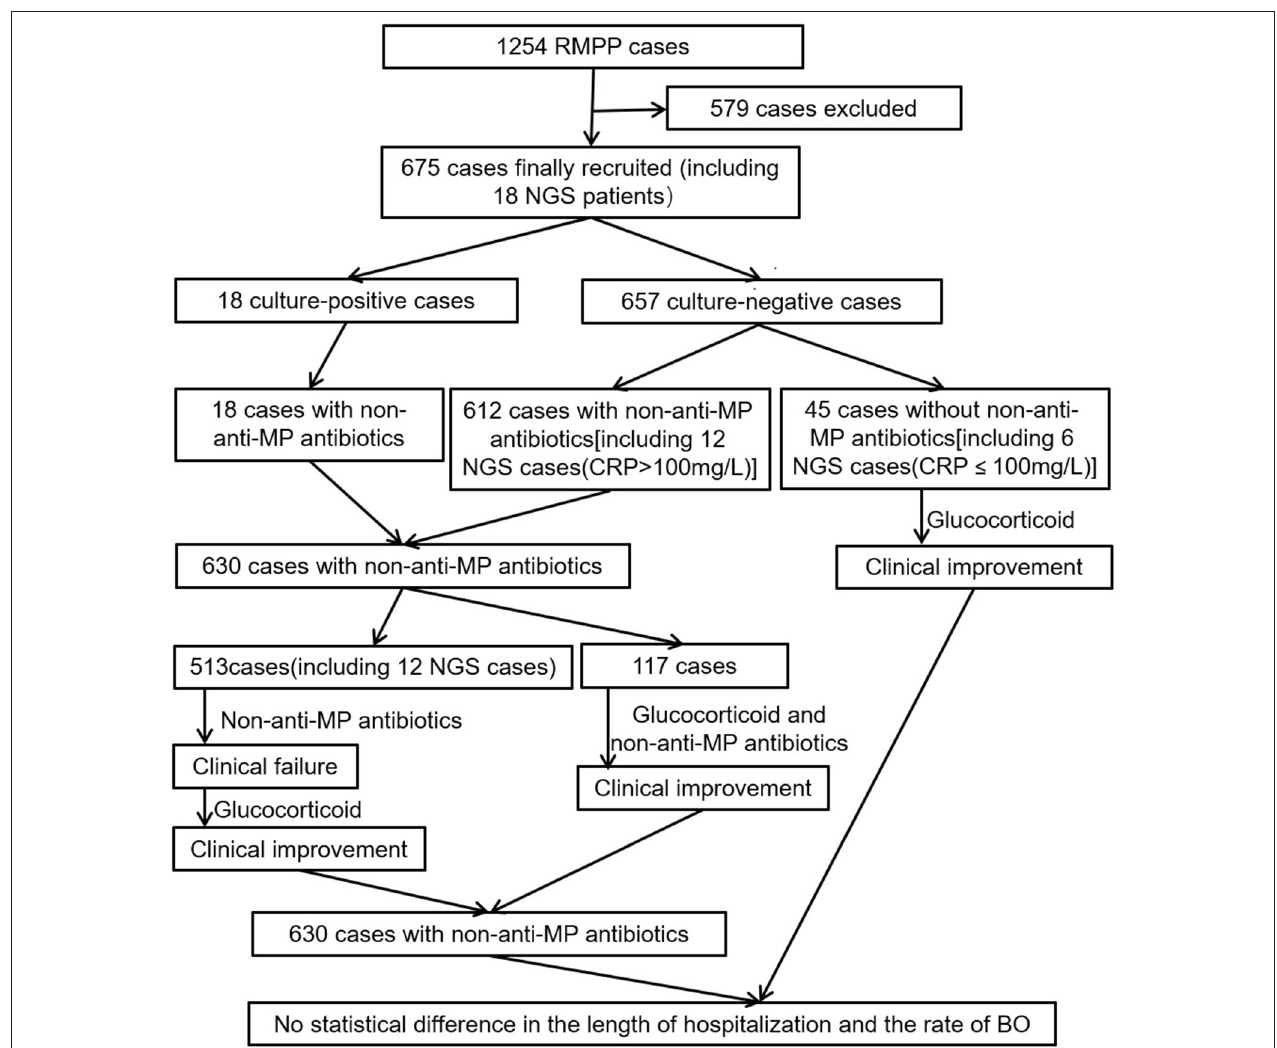
FIGURE 5 | Flow diagram of patient enrollment and